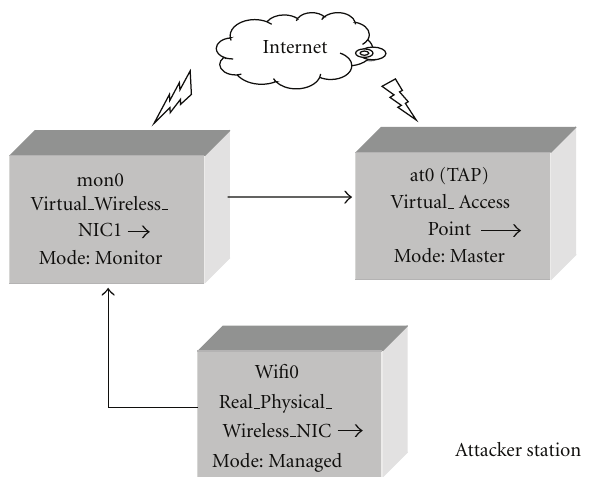
Figure 3: The new virtual wireless interfaces.